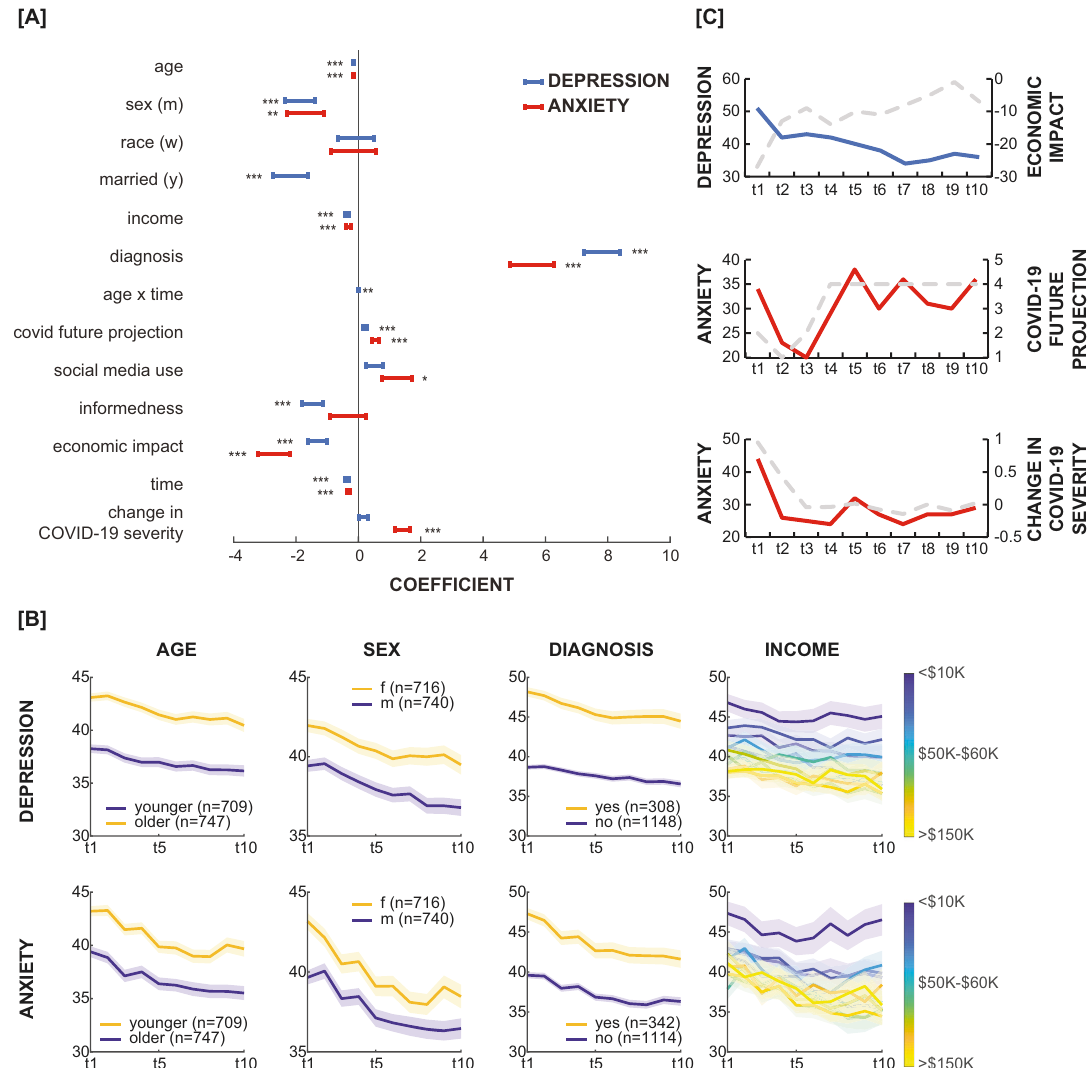
Fig. 3 Factors in fl uencing depression and anxiety during the COVID-19 pandemic in the United States. A The coef fi cients of a mixed- effects linear regression of depression (blue) and anxiety (red). Error bars represent con fi dence intervals. * p < 0.05, ** p < 0.01, *** p < 0.001. B Illustration of signi fi cant demographic variables related to depression and anxiety. Numbers in parentheses represent the number of participants at the fi rst time point, and plots are of all valid observations at each time point. C Example participants depicting signi fi cant behavioral and attitude variables related to depression and anxiety. Colored lines represent the example participant ’ s depression (blue) and anxiety (red). Dotted lines represent the same participant ’ s behavioral/attitude